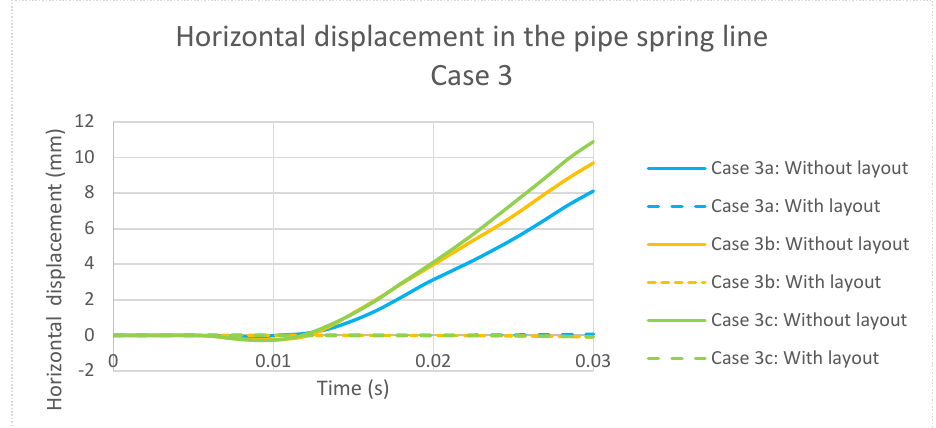
Figure 11. Horizontal displacements in the pipe spring line for case 2.